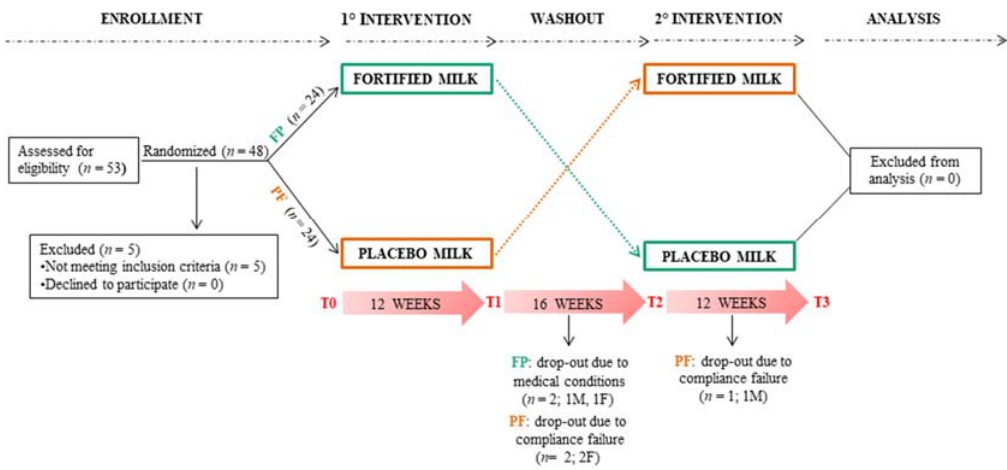
Figure 1. Flow chart of the 40-week study protocol with cross-over. Fifty-three subjects were assessed for eligibility for the study and 5 out of 53, not meeting inclusion criteria, were excluded. Forty-eight subjects were randomly allocated to the two study arms. One arm started the study with consumption of the fortified milk, while the other one started the study with the placebo milk and then each group was assigned to the opposite treatment. Both the treatment periods were 12 weeks long with 16 weeks of washout in between. Overall, five subjects left the study for medical conditions or failure to comply, four subjects left the study during the washout period, and one left the study after the washout. Volunteers were assessed at the baseline (T0) and the end of the first intervention (T1), the washout (T2), and the second intervention (T3). FP (green line) = arm: participants on fortified milk and then placebo, PF (orange line) = arm: participants on placebo and then fortified milk.